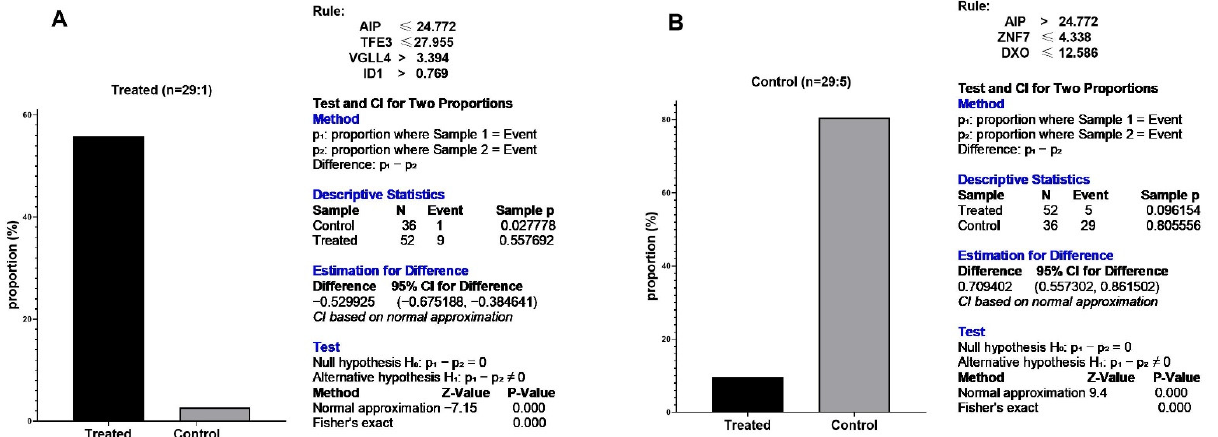
Figure 6. Regulatory signatures of herbal treatments on carcinogenic cells. ( A ): AIP/TFE3/VGLL4/ID1 rule induced in 55.7% of treated and 2.7% of control cases. ( B ): AIP/ZNF7/DXO rule was observed in 80.5% of control and 9.6% of treated samples. Proportion test by Fisher Exact test confirms the results of Random Forest where most of cells obey the rules belong to cancer.